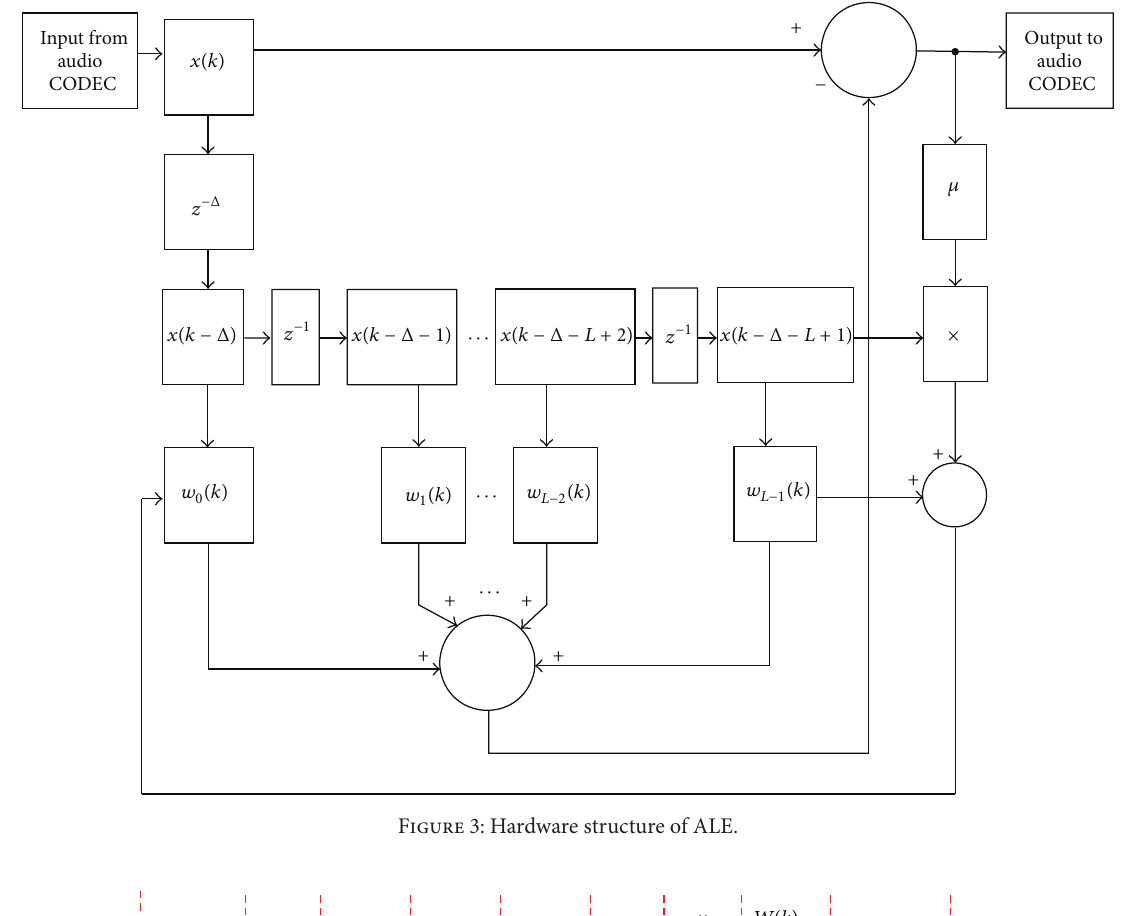
Figure 3: Hardware structure of ALE.